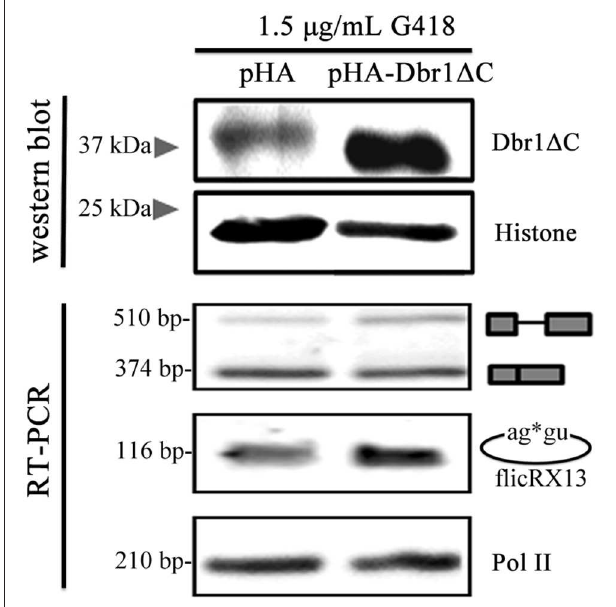
FIGURE 6 | flicRX13 is a postsplicing product: Dbr1 is involved in Entamoeba flicRNA production. E. histolytica trophozoites were transiently transfected with the empty vector pEhExHA (pHA), or with the C-terminus deleted Dbr1 (pHA-Dbr1 1 C) plasmids and 24h latter were tested under low selection pressure (1.5 µ g/mL G418). Overexpression of Dbr1 (wt or 1 C) was monitored by western blot using anti-HA antibody compared to anti-histone H3 (loading control). The effect of Dbr1 (wt or 1 C) overexpression on flicRX13, RabX13 mRNA, and RNA Pol II (loading control) gene expression was analyzed by RT-PCRs.